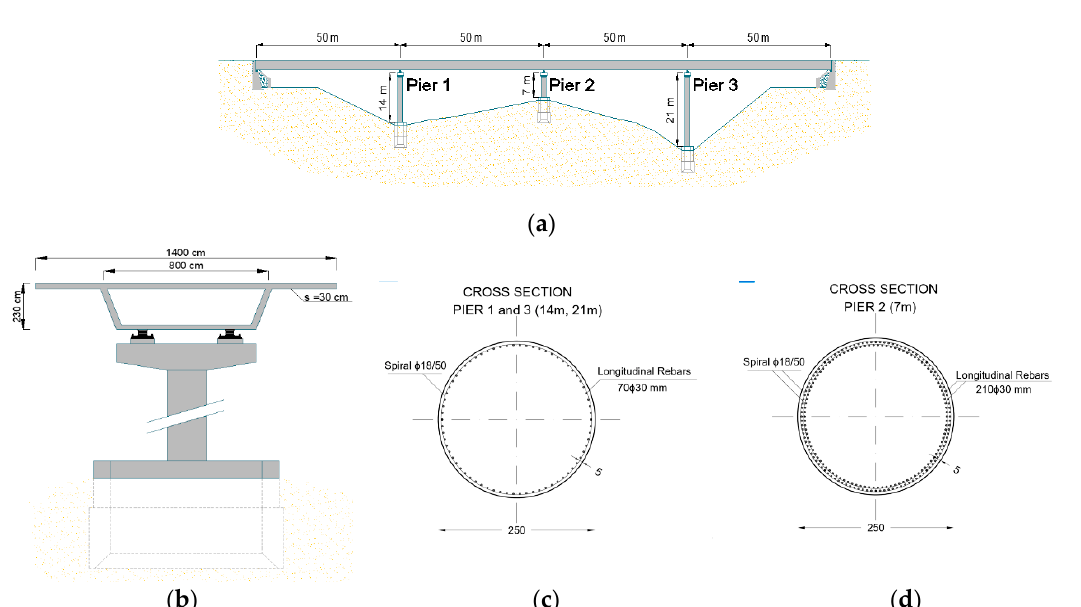
Figure 2. Structural details of selected bridge: ( a ) longitudinal view, highlighting the piers and span